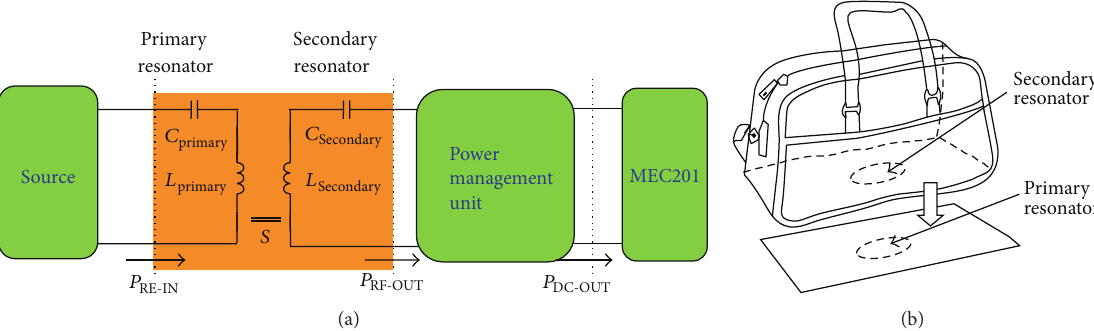
Figure 1: Proposed wireless charger. (a) Schematic representation: the link consists of a wireless resonant energy link and of a power management unit. (b) Example of application: the secondary resonator is embedded into a leather bag, while the primary resonator is on a pad where the bag should be placed on for charging the battery.